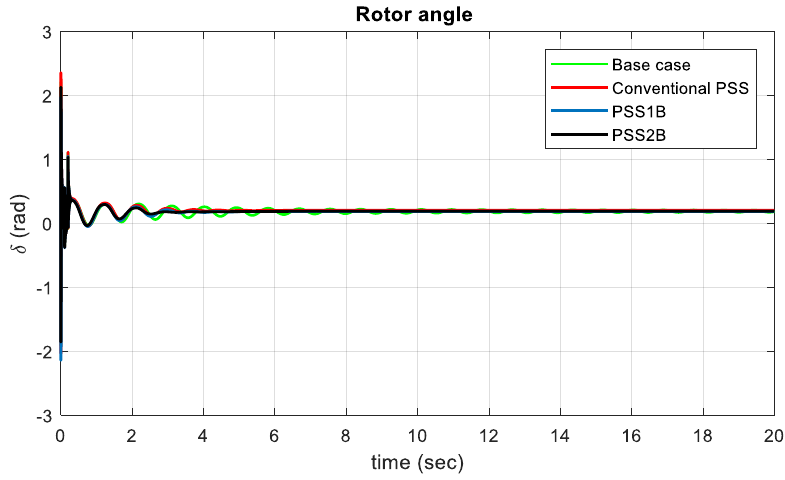
Figure 23. Rotor angle of the power system at light loading.